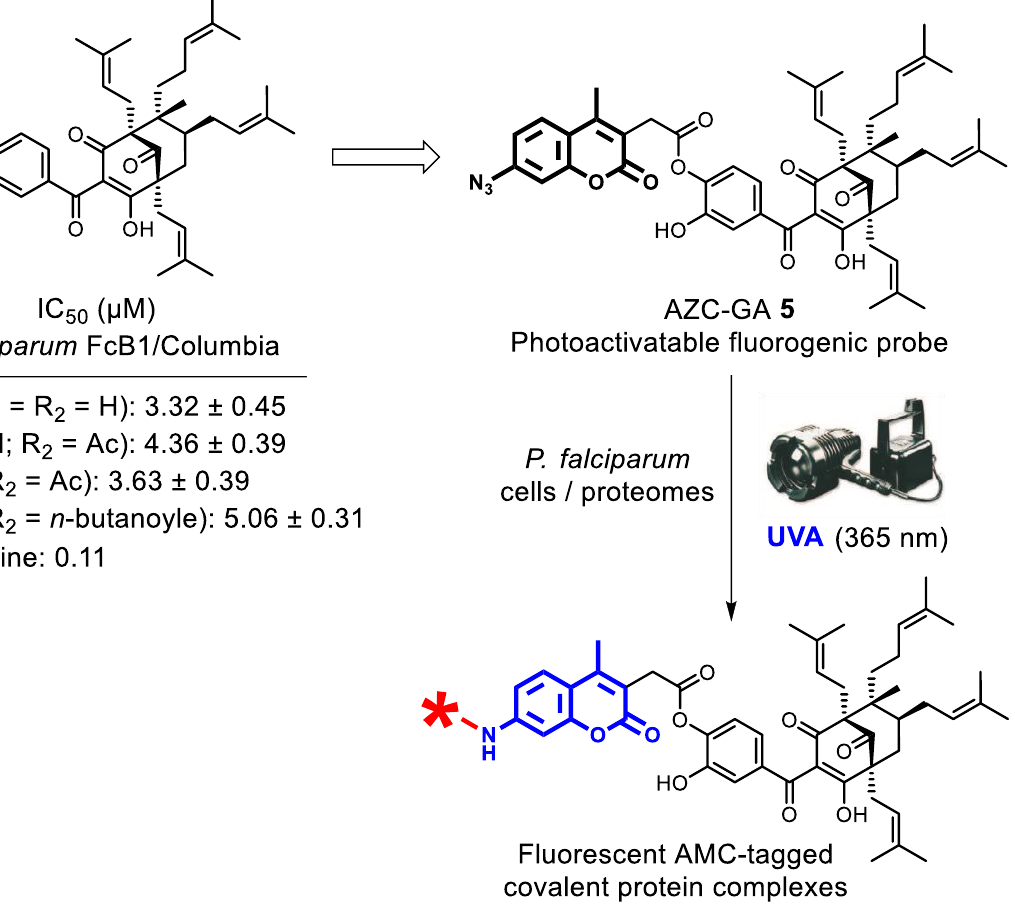
Figure 2. SARs in ester series [11] for the design of photoactivatable probe AZC-GA 5 , and its principle of fluorogenic covalent capture of a ffi nity proteins (star =